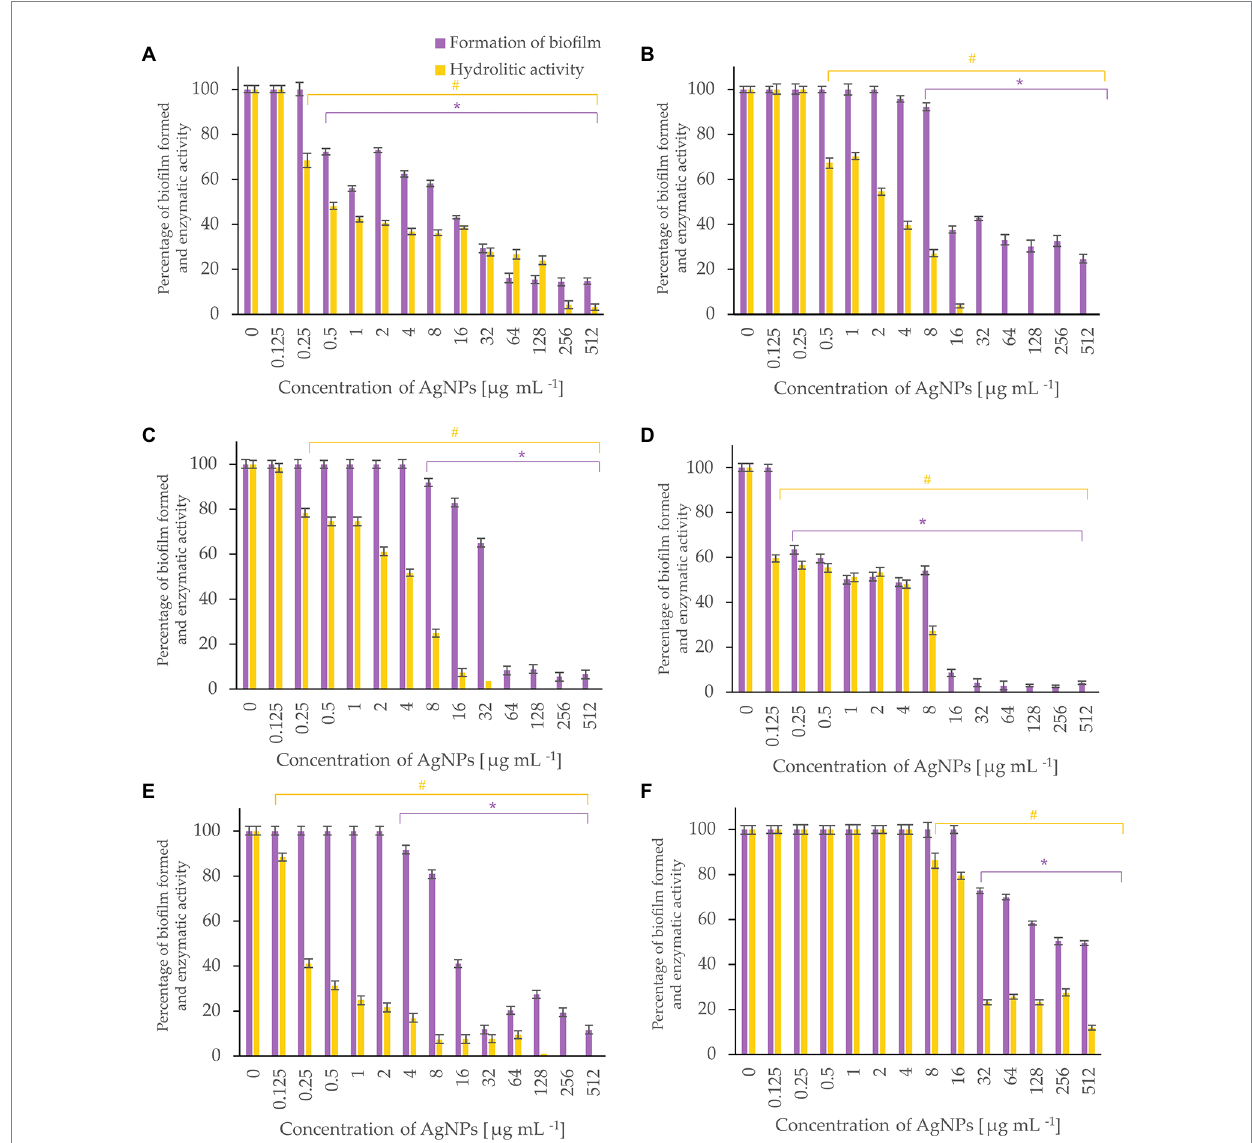
FIGURE 5 Percent of bacterial biofilm formation and hydrolase activity in biofilms after treatment with various concentrations of AgNPs from F. culmorum strain JTW1. E. coli ATCC 25922 (A) , E. coli ATCC 8739 (B) , K. pneumoniae ATCC 700603 (C) , P. aeruginosa ATCC 10145 (D) , S. aureus ATCC 25923 (E) , S. aureus ATCC 6538 (F) . The statistical significance (value of p < 0.05) of tested variants (different concentrations of AgNPs) compared with untreated control were indicated by * and # signs for biofilm formation and hydrolytic activity tests,